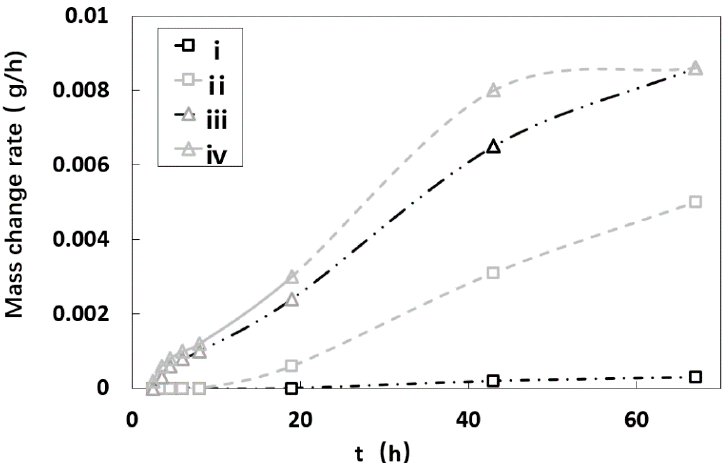
Figure 12. Evaporation rate curves of different samples.